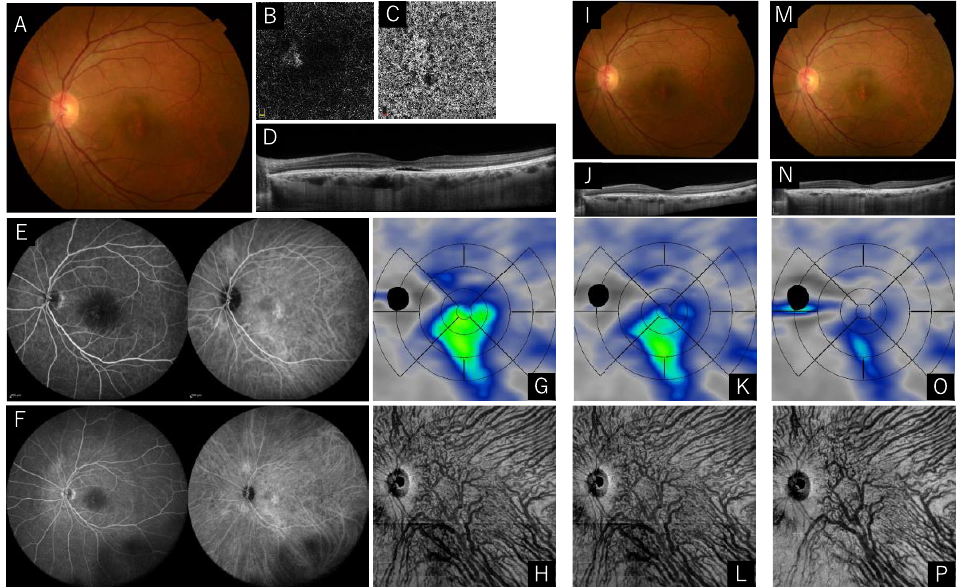
Figure 3. Images of the right eye of a 58-year-old male with pachychoroid neovasculopathy. ( A – H ) Images before treatment, and ( I – L ) three months and ( M – P ) one year after combination therapy. ( A ) Color fundus photograph shows the subretinal detachment. ( B , C ) Optical coherence tomography (OCT) angiography of the outer retina and the choriocapillaris slabs shows choroidal neovasculari- zation. ( D ) The OCT horizontal scan thorough the central fovea shows subretinal fluid and pach- yvessels with inner choriocapillaris attenuation. ( E , F ) Fluorescein angiography demonstrates faint leak points, and indocyanine green angiography presents hyperfluorescein spots and choroidal vas- cular hyperpermeability. ( G ) Choroidal thickness map shows greater choroidal thickness in central and inferior areas. ( H ) En face OCT image in the deep layer of the choroid represents dilated cho- roidal vessels, and horizontal watershed zone is not observed. ( I , J ) Three months after the treatment, subretinal fluid disappeared, and pachyvessels diminished. ( K , L ) Choroidal thickness map shows reduction in choroidal thickness in the central area, and the en face OCT image shows persistently dilated choroidal vessels and lost horizontal watershed zone. ( M , N ) No recurrence was exhibited at one year after the treatment. ( O ) Choroidal thickness map shows reduced choroidal thickness in the central area and the inferior area. ( P ) The constriction of choroidal vessels imaged by en face OCT persisted in the macular area, while the diminished choroidal vessels were also seen in the inferior area.